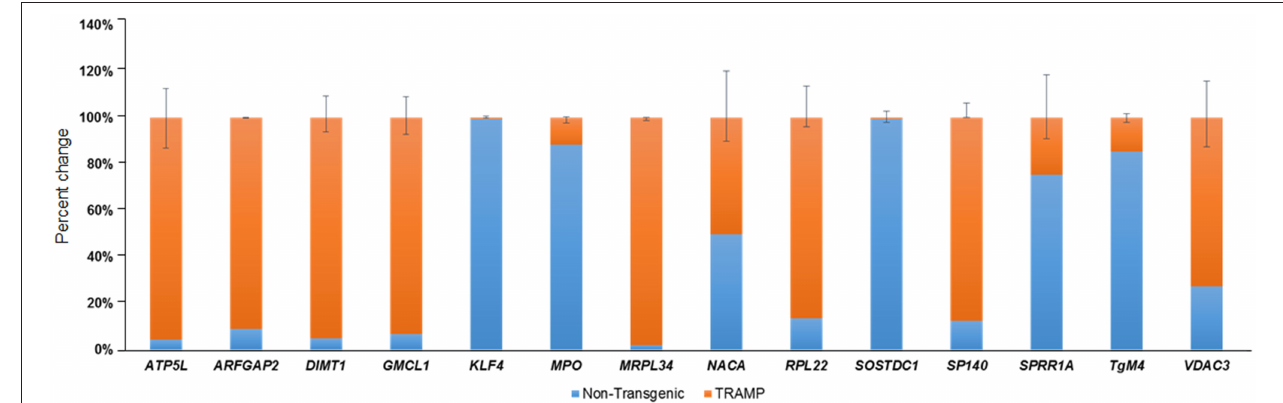
FIGURE 2 | Transcriptional changes of select number of transcripts identified by microarray in non-transgenic and TRAMP mice and their validation by qRT-PCR. Percent change in ATP5L, ARFGAP2, DIMT1, GMCL1, KLF4, MPO, MRPL34, NACA, RPL22, SOSTDC1, SP140, SPRR1A, TgM4, and VDAC3 genes are shown. Values represented in the graph are percentage (%) change of transcript abundance between TRAMP mice compared with non-transgenic littermates. Error bars are standard error of percent changes driven from three biological and technical replicates. The orange color in the graph represents the expression of genes in TRAMP mice compared to blue which represent the non-transgenic mice gene expression. Mean ± standard error. Student’s t -test for independent groups; p < 0.01; ( n = 3).